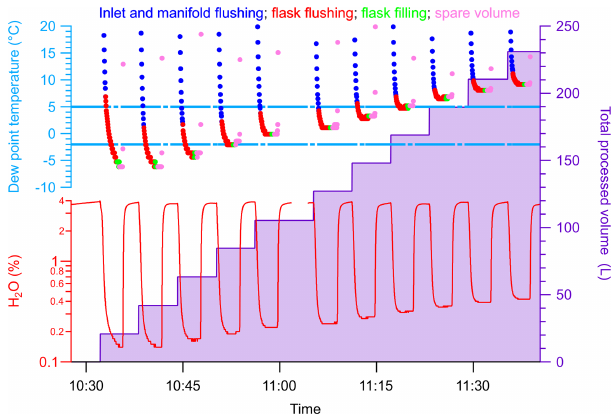
Figure 2. A time series mimicking the sample collection process during a flight to demonstrate the usability and the response of the Nafion™ dryer under conditions similar to those of the trop- ics (sample air with 3.7%–3.9% water vapor content at ∼ 33 ◦ C). The bottom panel (left) shows the water vapor content in the sam- pled air, the top panel (left) shows the corresponding dew point temperature (at 275kPa) and the panel on the right shows the to- tal processed volume. Periodically, humid air from the test facility was passed through the NAD, indicated by the dips in the water va- por content (%) of the sampled air, to simulate a complete filling step of a PFP flask. These steps are indicated in the dew point plot as follows: (1) flushing of the inlet and the manifold volume (blue points), (2) flushing of the inlet and manifold volume plus the flask (red points), and (3) filling of a flask (green points). A slight amount of excess air was processed in every passing through the Nafion™ dryer, indicated by the pink points. The targeted dew point temper- ature was − 2 ◦ C, and as can be seen, the drying unit is capable of drying approximately 85L of air containing 3.7%–3.9% H 2